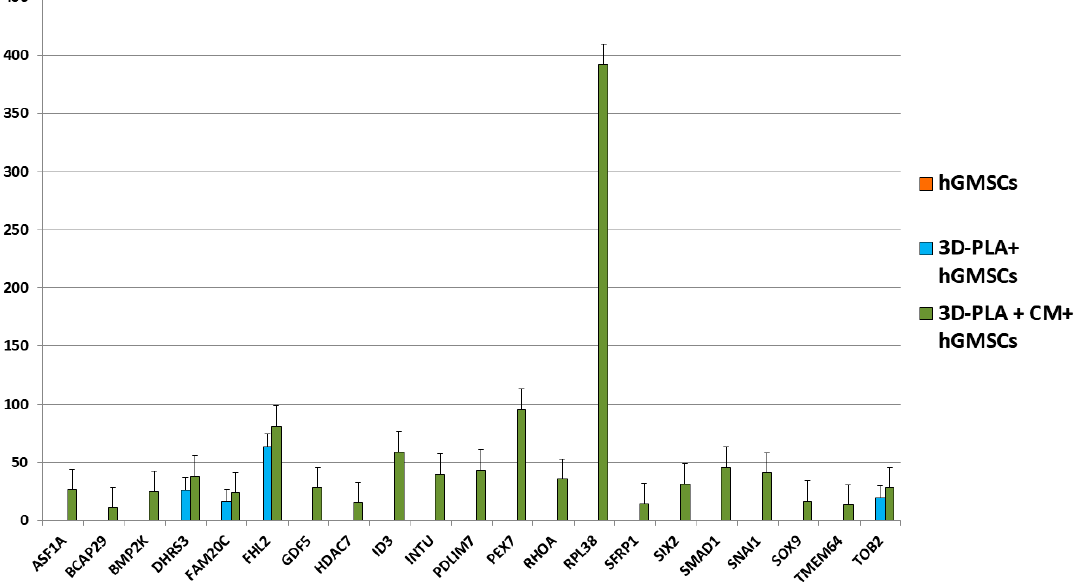
Figure 4. Expression levels of genes differentially expressed in hGMSCs, 3D-PLA + hGMSCs and 3D-PLA + conditioned medium (CM) + hGMSCs (false discovery rate (FDR) < 0.05; n = 3). Gene expression levels, fold changes, gene ontology (GO) processes and false discovery rate (FDR) were reported in Table 1.